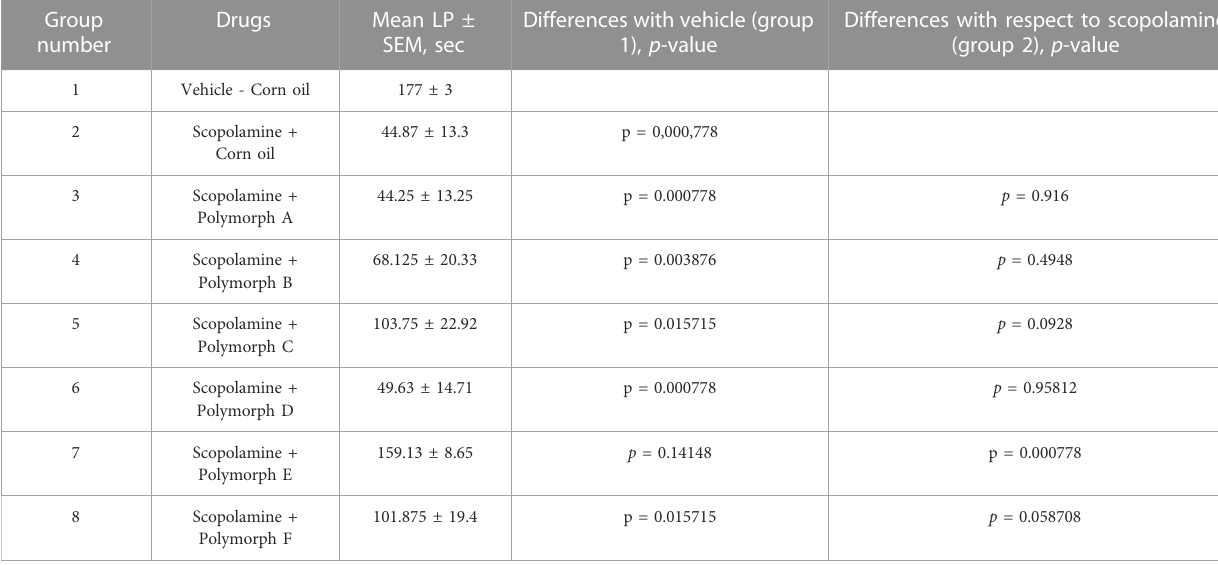
TABLE 10 Latent period (LP) of transition to the dark chamber in PA test 24 h after training. Group number